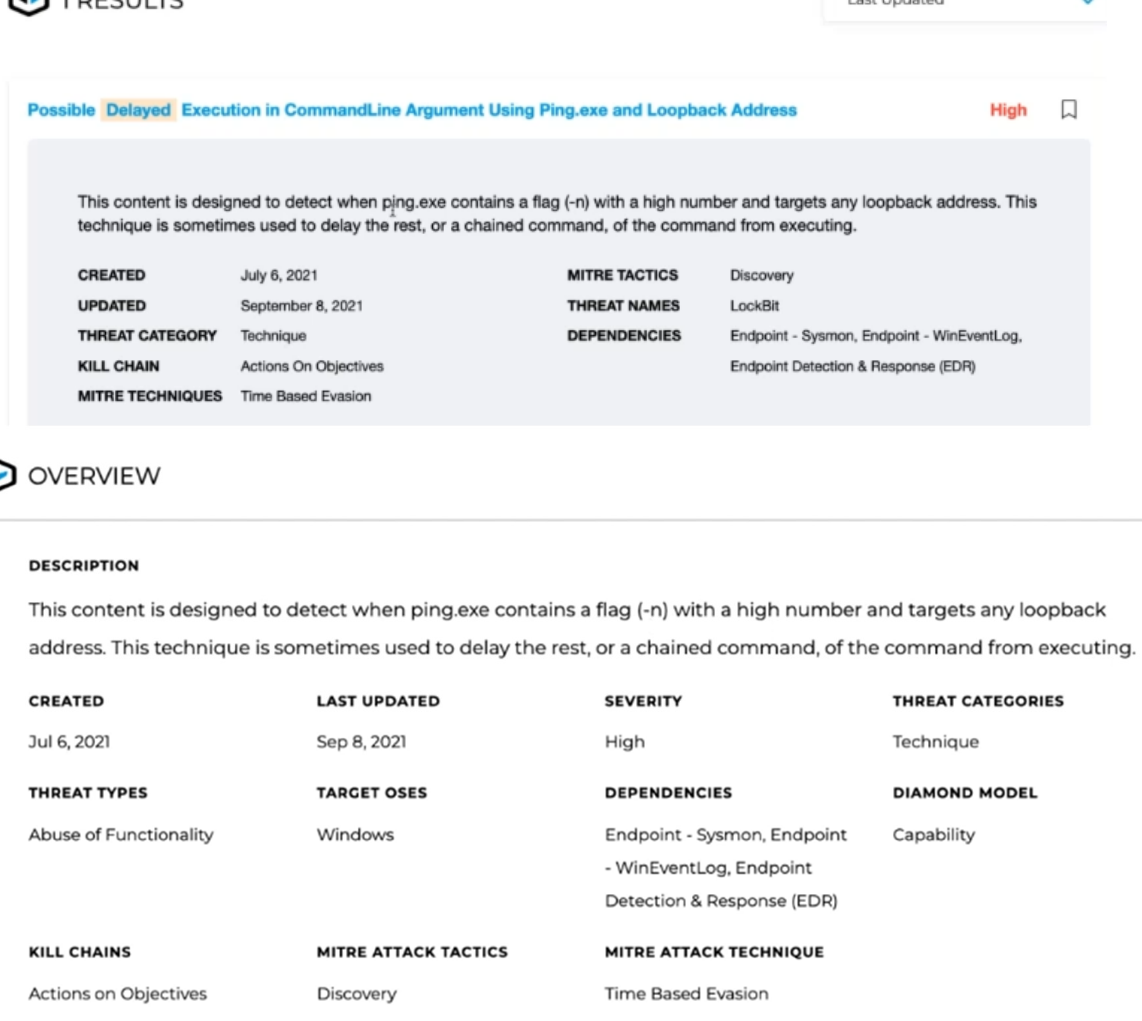
Figure 11. Delayed execution search and overview.